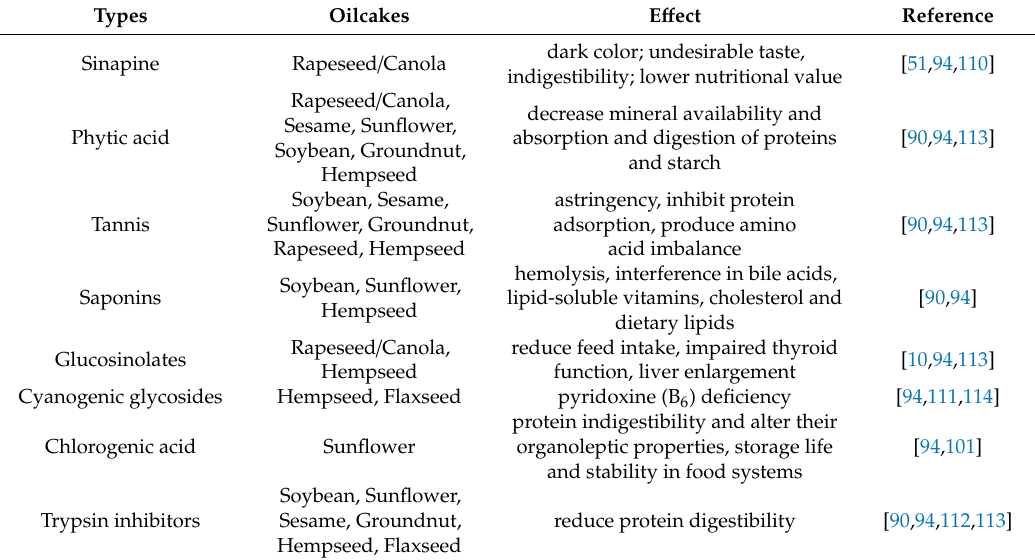
Table 2. Main antinutritional